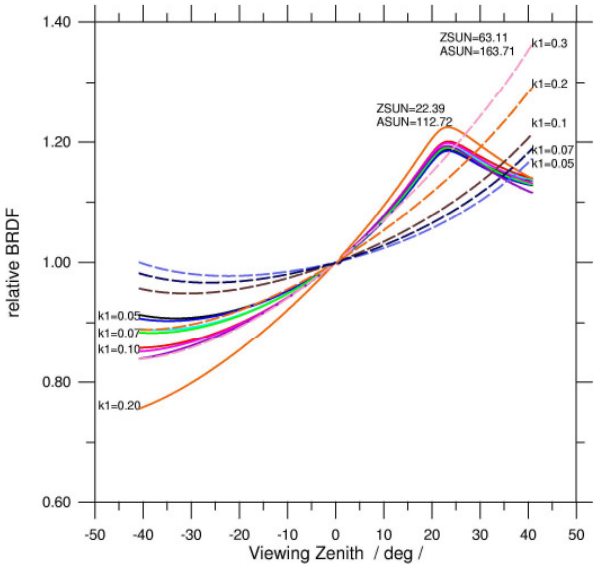
Fig. 3. Relative BRDF calculated for two illumination conditions (solar zenith angles 22.39 ◦ and 63.11 ◦ ) and the viewing range of MERIS for different parameters of the RPV model, used in the VIS